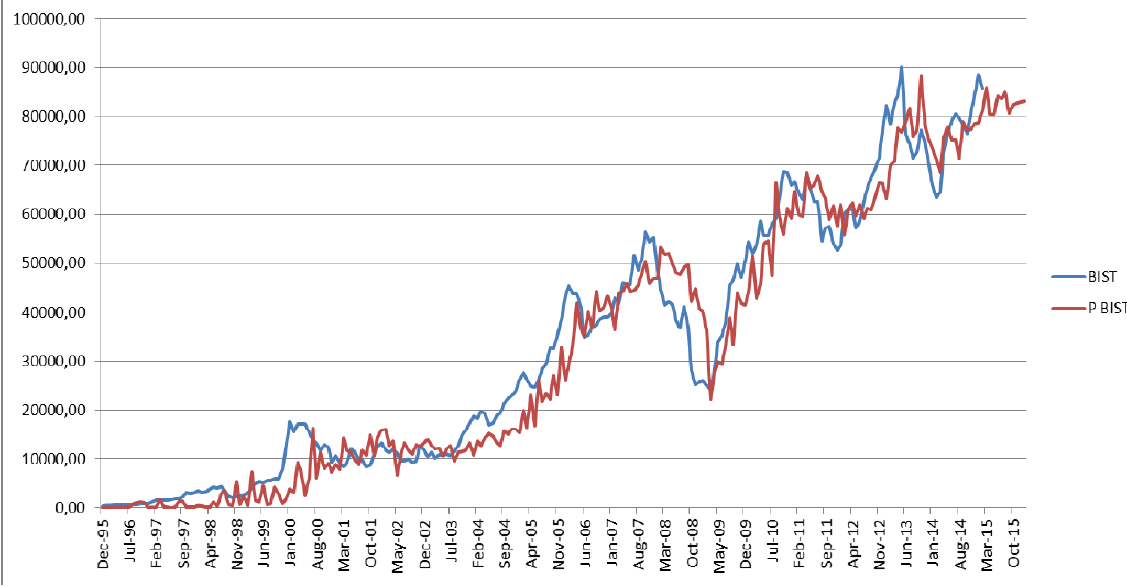
Figure 4. The comparison between the actual values (BIST) and the predicted values (PBIST) obtained by the second ANN